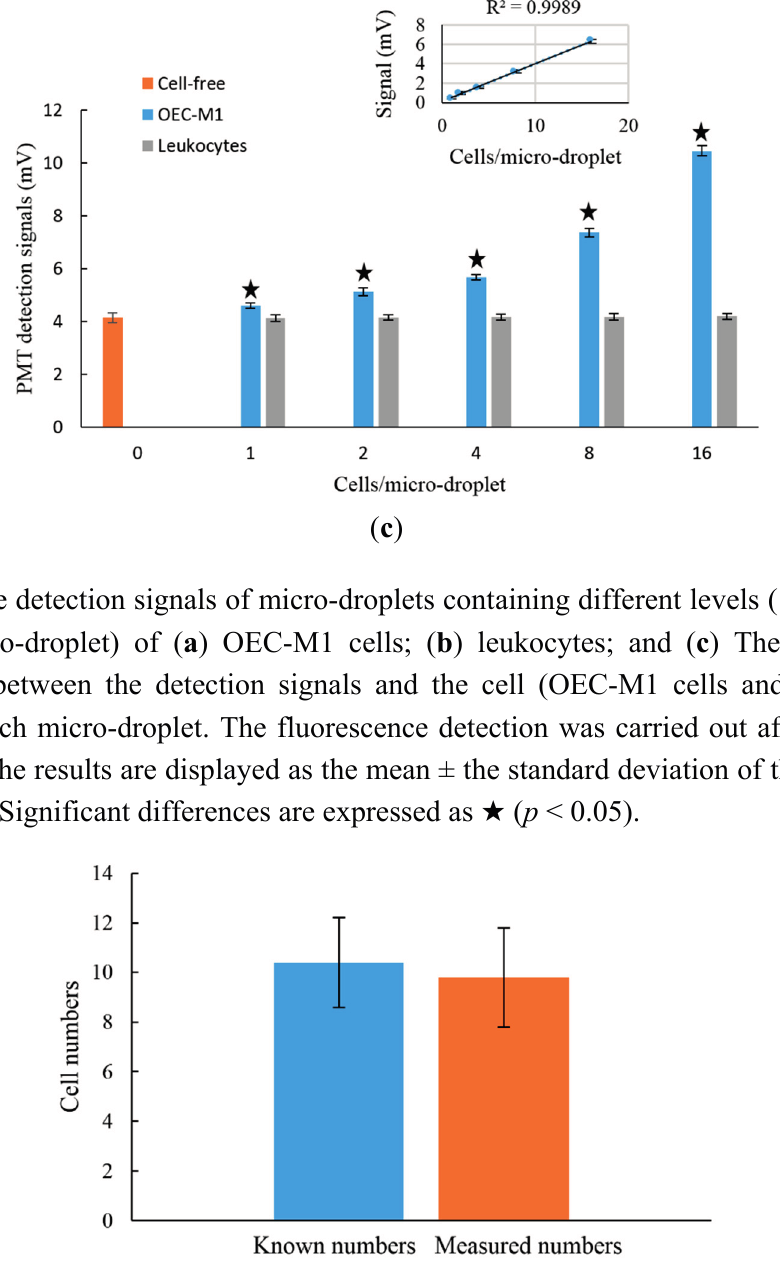
Figure 5. The experimental quantification of the number of OEC-M1 cells through the proposed method and its comparison with the calculated number. The results are displayed as the mean ± the standard deviation of 3 separate